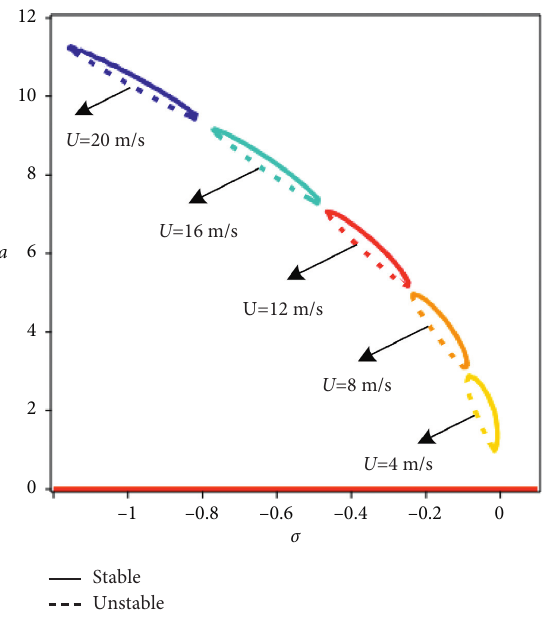
Figure 16: The 1/3-order subharmonic amplitude-frequency re- sponse curve (varied U ).